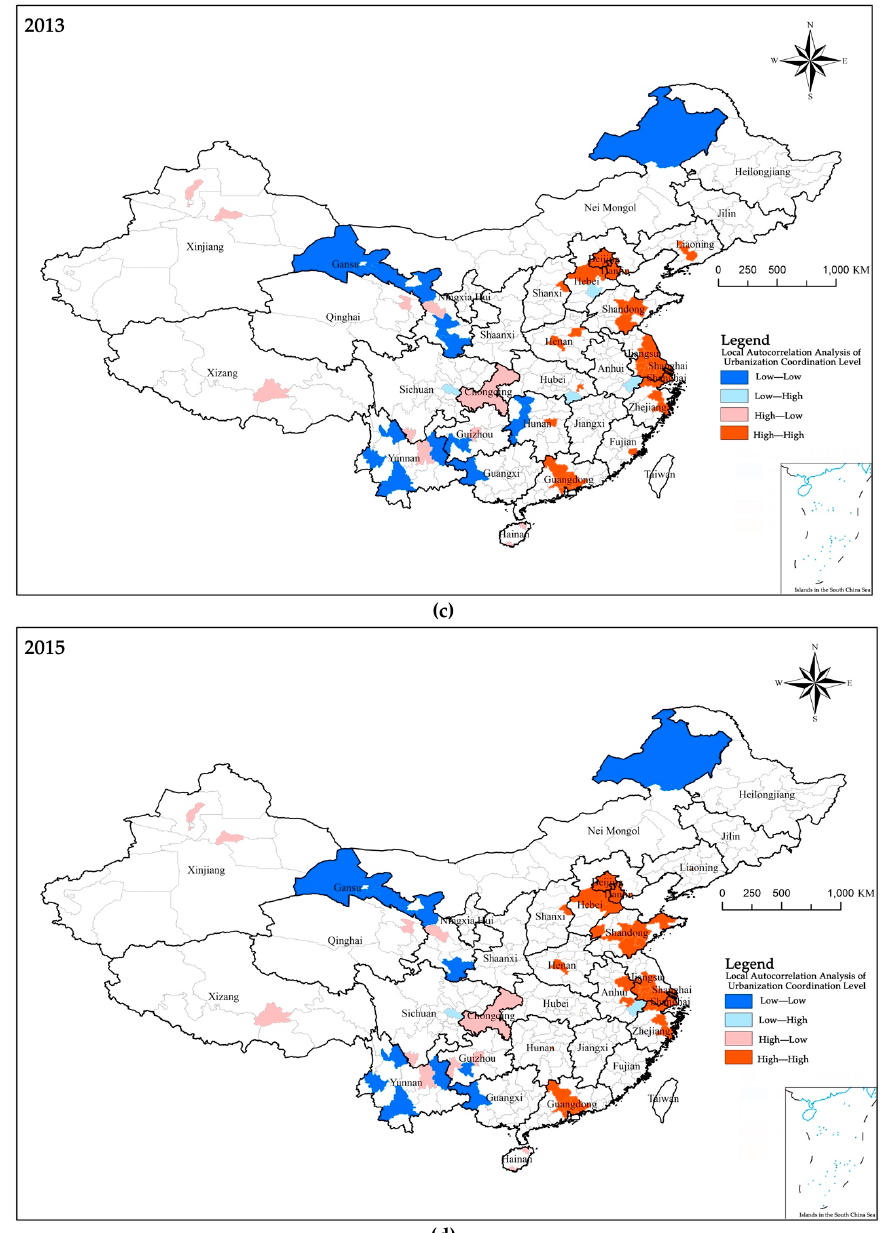
Figure 5. Local autocorrelation analysis of urbanization coordination level in China:(a)2005;(b)2010;(c)2013 and (4)2015.